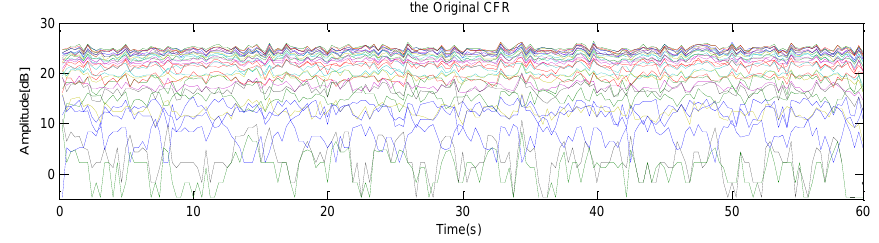
Figure 15. The CFR of all subcarriers for abnormal breathing.